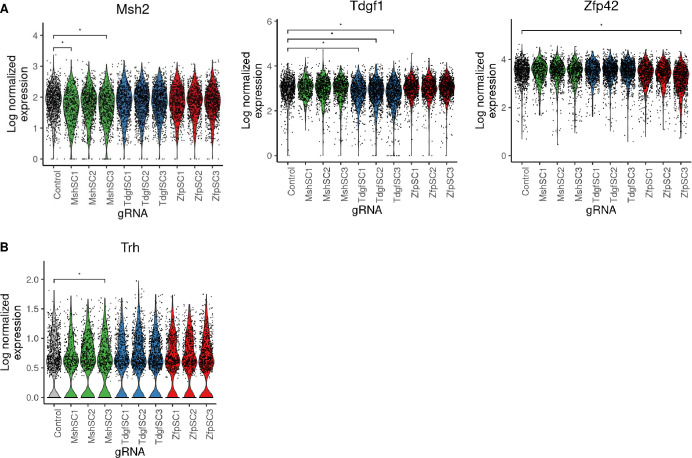
Detection of rare loss of expression events caused by CRISPR/Cas9 non-coding mutation in wildtype cell pools.(A) Violin plots showing log normalized expression of Msh2 (left), Tdgf1 (middle), and Zfp42 (right) with transcript-targeted sequencing in the unsorted experiment. * denotes statistical significance at adjusted p-value < 0.05. (B) Violin plots showing log normalized expression of Trh, which is down-regulated in cells where Msh2 was also observed to be significantly down-regulated. * denotes statistical significance at adjusted p-value < 0.05.